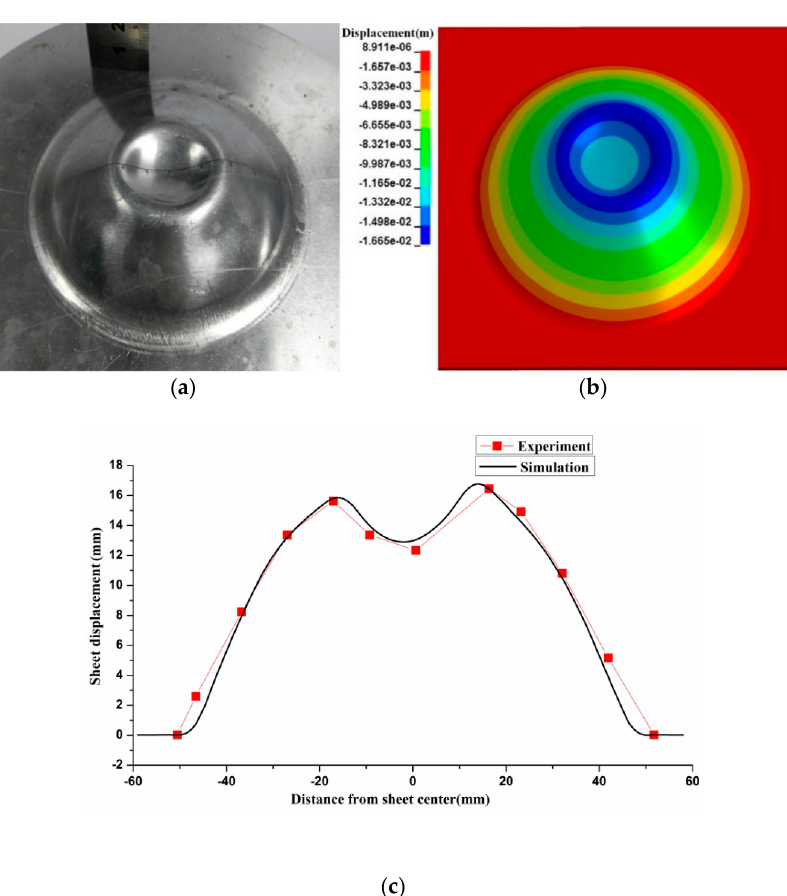
Figure 14. Deformation height and shape profiles of high-speed impaction at a discharge voltage of 10 kV: ( a ) experiment result; ( b ) simulation result; and ( c ) comparison of the profiles between the experimental and simulated results along the central plane.